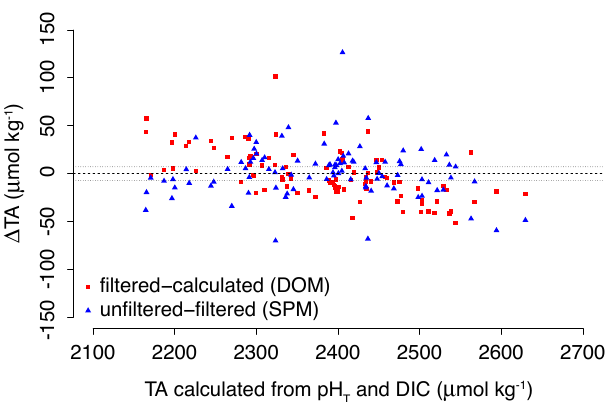
Figure A2. Differences in partial pressure of CO 2 ( (cid:49)p CO 2 ; ppmv) measured by the headspace technique using gas chromatography and calculated using a suite of parameter combinations (pH T and DIC, TA and DIC, pH T and TA). TA FI and TA UF indicate TA mea- sured on filtered and unfiltered samples,